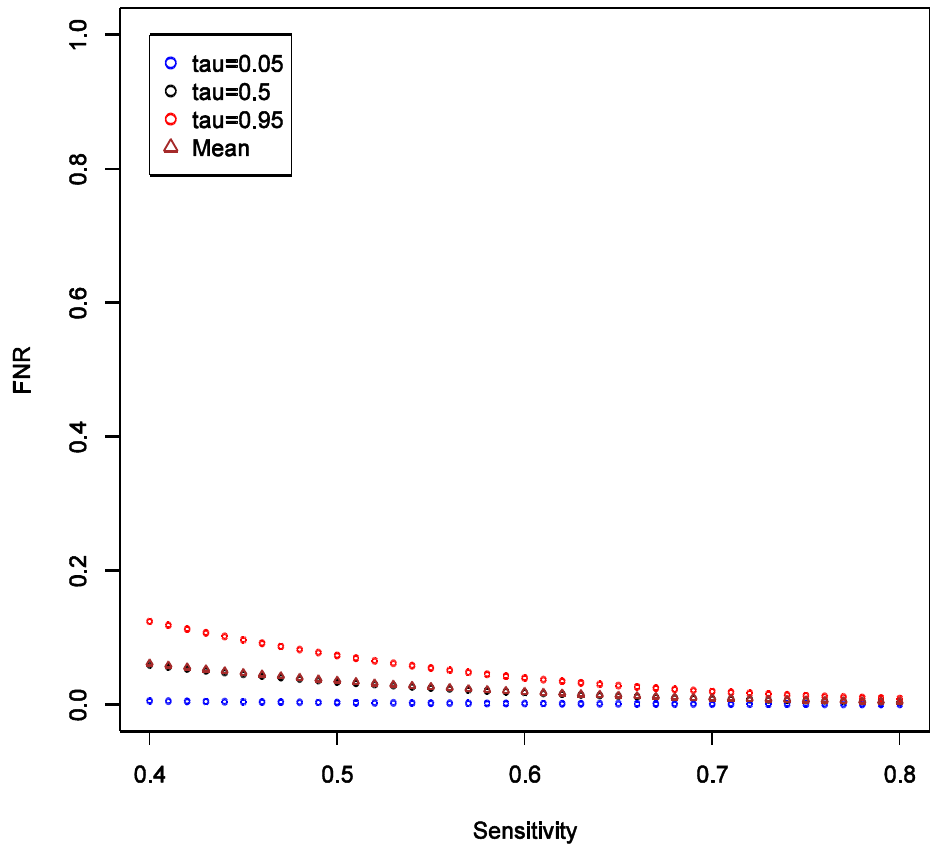
Figure 4. Theoretical calculations of the impact of varying sensitivity of exposure classifier while keeping specificity fixed at 0.9; tau (τ) = expected quintiles of the distribution for false positive negative (FNR); see text for details of other parameter